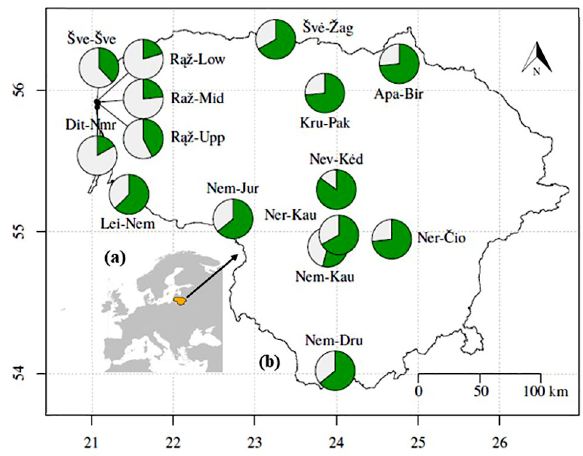
Figure 1. Geographic location of Lithuanian populations of Lythrum salicaria based on the data of Bayesian analysis in STRUCTURE: clustering plot of populations using pie diagrams (two gene pools labelled in white and green) to indicate the proportion of membership of each K = 2 clusters in the populations